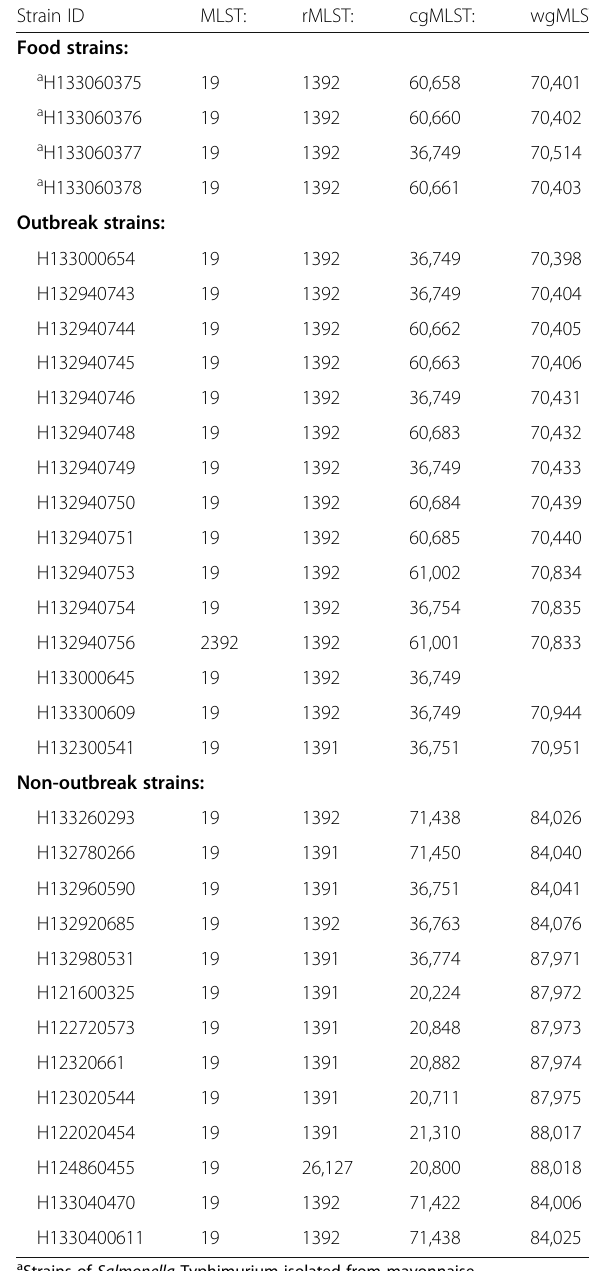
Table 2 MLST, rMLST, cgMLST and wgMLST results of